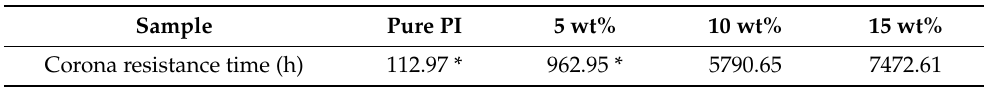
Table 2. Corona-resistant lifespan of pure PI films and PI/SiO 2 composite films with different doping amounts at 20 kV/mm.